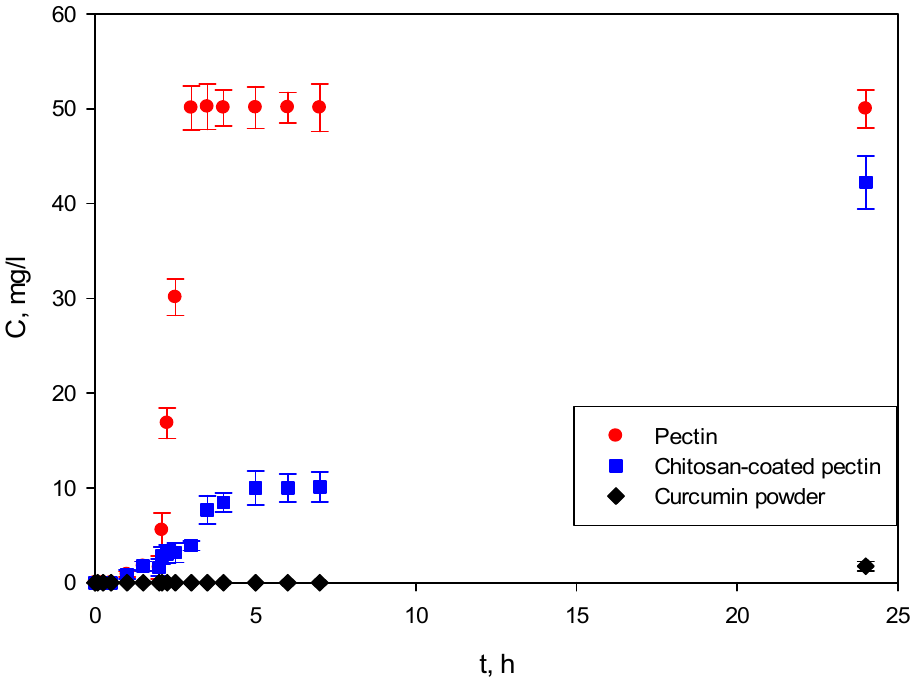
Figure 10. In-vitro curcumin release studies: 2 h in SGF followed by 22 h in SIF, 24 h overall.